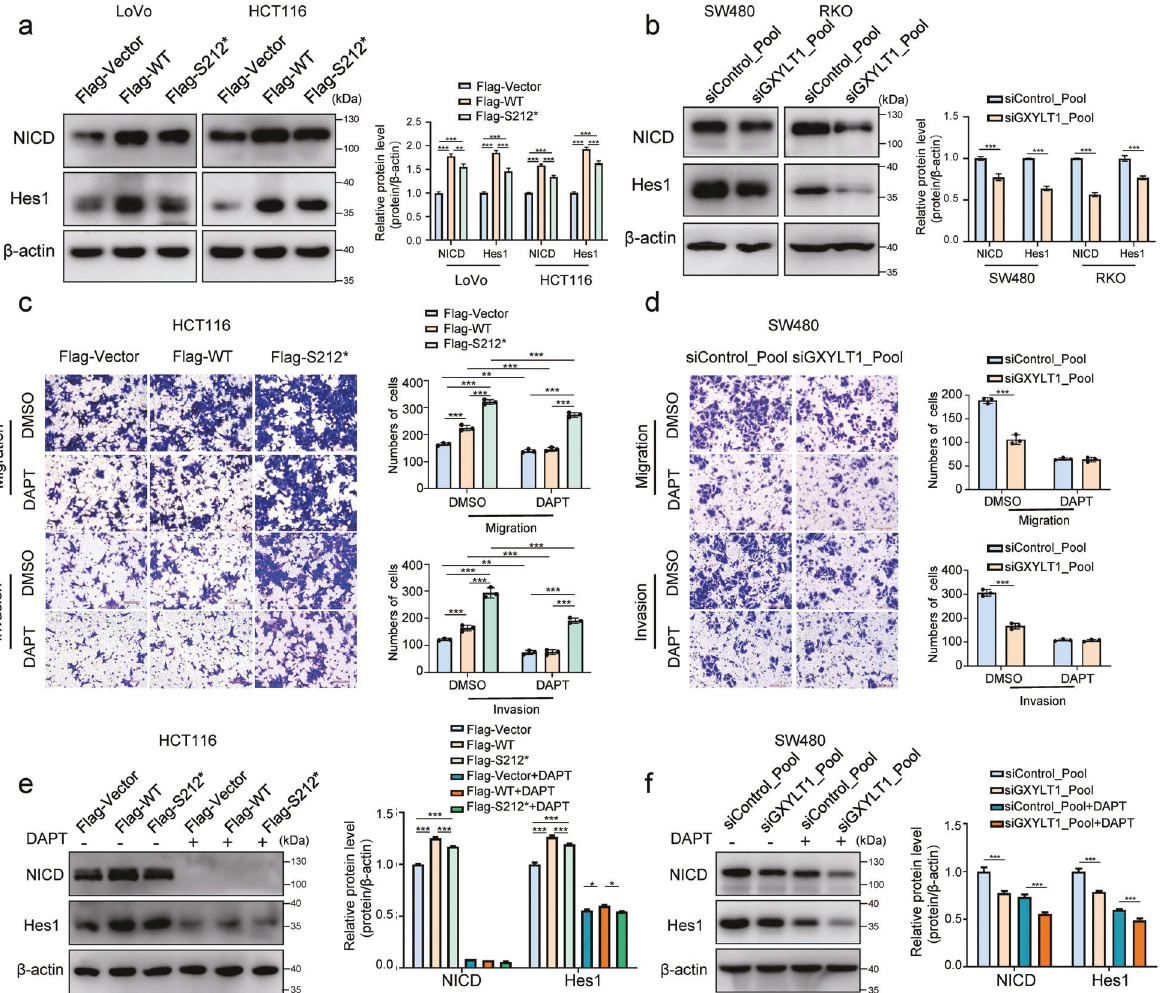
Fig. 5 GXYLT1 S212* promotes migration and invasion partially via the Notch pathway, unlike Notch pathway dependence of WT GXYLT1. a , b Western blot analysis of the protein levels of the Notch protein intracellular domain (NICD) and Hes1 in CRC cells transfected as indicated. Bar graphs show quantitative analysis of protein levels. c , d Transwell migration and invasion assays of transfected CRC cells treated with the Notch pathway inhibitor DAPT or the DMSO control for 48 h. Charts show quanti fi cation of migrated cells. e , f Western blot analysis of NICD and Hes1 in cell lysates. Bar graphs show quanti fi cation of NICD and Hes1 protein levels. Data are presented as the mean ± SD of at least three independent experiments. * p < 0.05, ** p < 0.01, *** p <